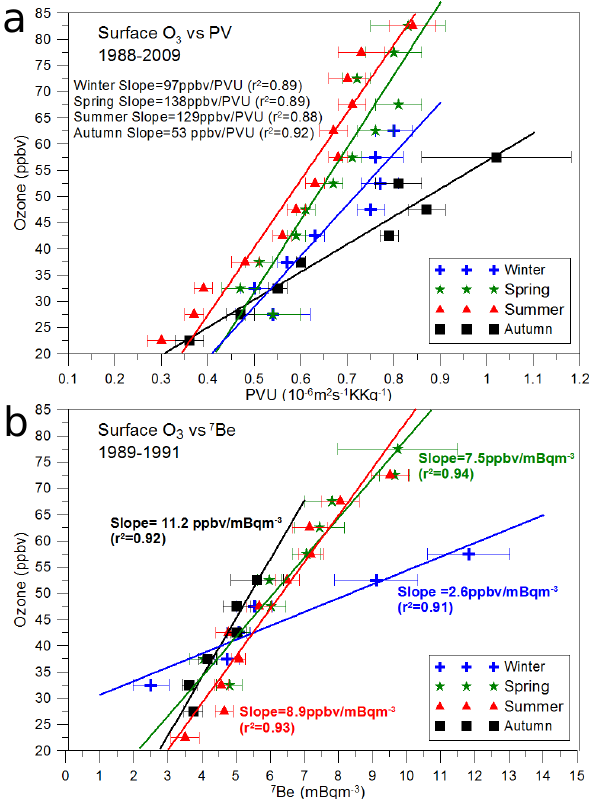
Fig. 9. (a) PV max ( 1PVU = 10 − 6 m 2 s − 1 KKg − 1 ) vs. surface O 3 (ppbv) at IZO for winter (JFM), spring (AMJ), summer (JAS) and autumn (OND) in the period 1988–2009. (b) 7 Be ( mBqm − 3 ) vs. O 3 ozone (ppbv) at IZO for the same seasons in the period 1989–1991. Data have been grouped and depicted as for Fig. 8.